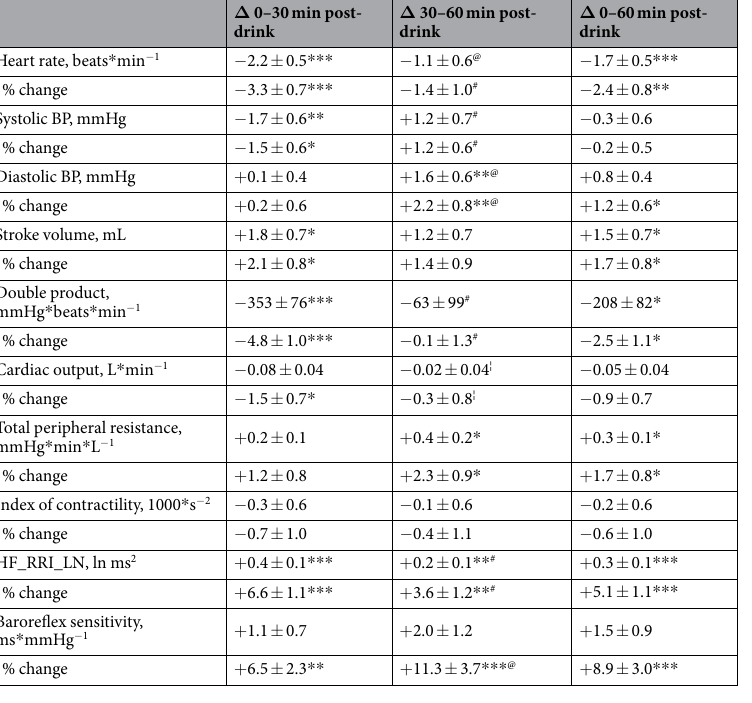
Table 2. Post-water cardiovascular- and autonomic responses relative to baseline values and presented as a delta ( Δ ). Values are means ± SEM (standard error of the mean); BP: blood pressure; HF-RRI_LN: high frequency component of RR-interval; ln: natural logarithm; Δ 0–30 min, Δ 30–60 min, and Δ 0–60 min: 0 minutes denotes four minutes after the water drink with calculating a subsequent average over the following 30 minutes, 30 to 60 minutes, and 0 to 60 minutes post-drink, respectively, which were subtracted from each baseline level and presented as deltas. * P < 0.05, P < 0.01, and *** P < 0.005 statistical significant differences using a paired student’s t -Test, where each post-drink period was compared to its baseline values. ¦ P < 0.05, @ P < 0.01, and # P < 0.005 statistical significant differences using a paired student’s t -Test comparing the changes over 0–30 min with the changes over 30–60 min